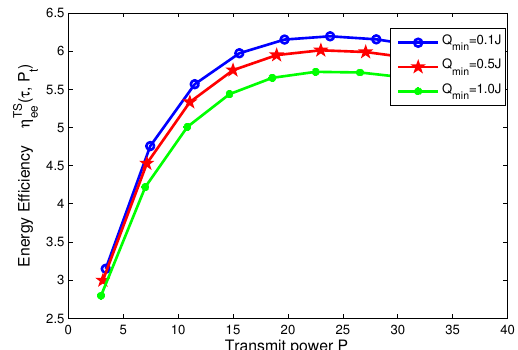
Figure 14. Energy efficiency versus transmit power with different minimum harvested energy requirements for TS mode.